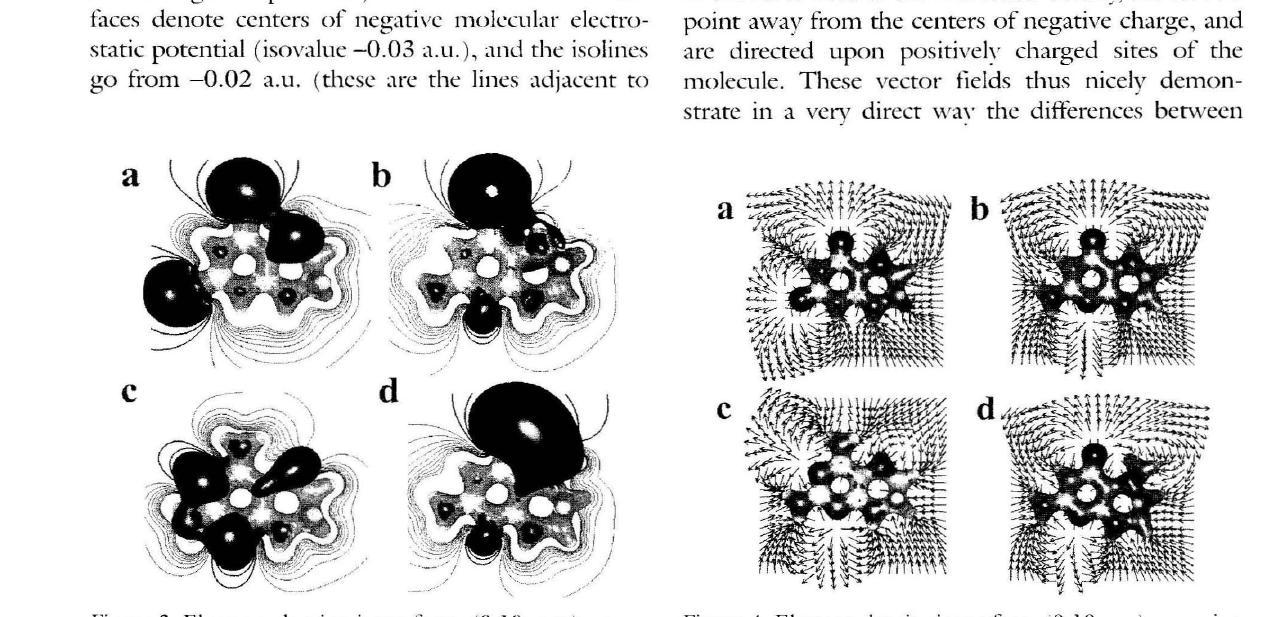
figure 3. Electron dens in' isosurfaces (0.10 a.lI. ), map ping local electrostatic potential, and isolincs and isosurfaces depicting the molecular electrostatic potential tlmctions of the compounds studied (see text for derails). a) tetrahydrolumazine, b) tctralwdropterin, c) 4-amino tetrahydropterin, d) NS-meth\,l tetralwdropterin.